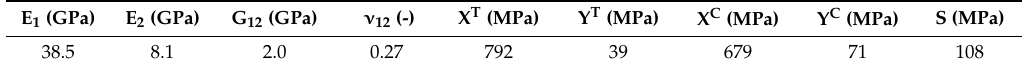
Figure 1. Considered channel section profiles ( a ) with cross-section dimension ( b ). Table 1. The material properties laminate under consideration [30].